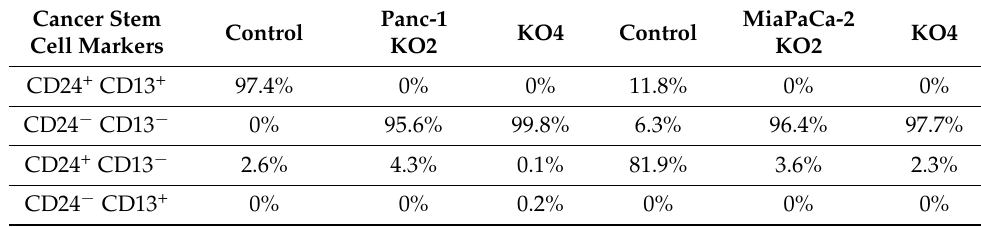
Table 1. Percentage of expression of CD24 and CD13 in PDAC Cell Lines.